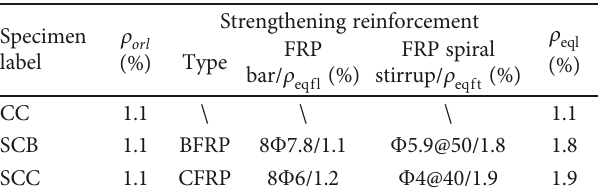
Figure 3: Real column and column Table 1: Details of all the specimens.